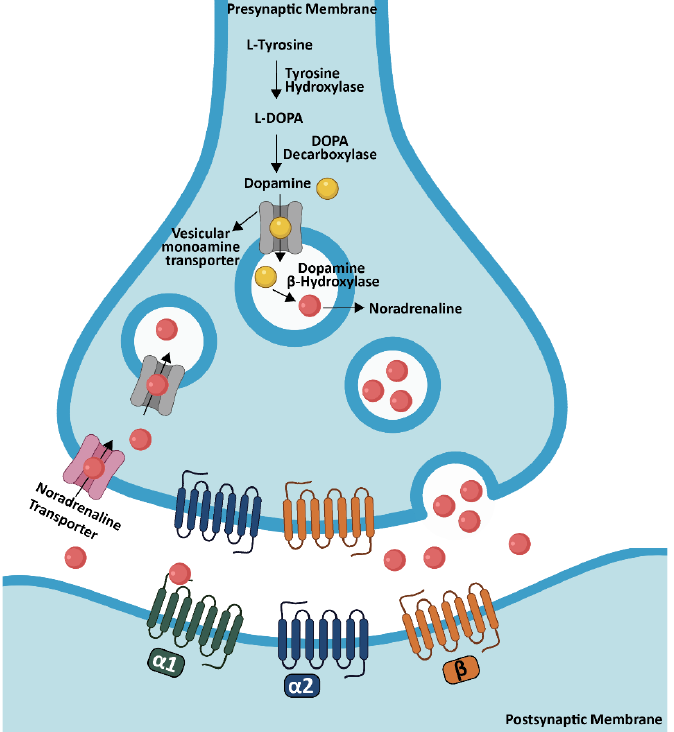
Figure 5. NA synthesis in the brain. NA synthesis is performed from dopamine through DBH in the LC and transported into synaptic vesicles by a vesicular monoamine transporter. After NA is released into the synaptic cleft, it binds to specific adrenergic receptors in order to activate the signaling for the specific task. Created partially with BioRender.com (accessed on 28 June 2021).